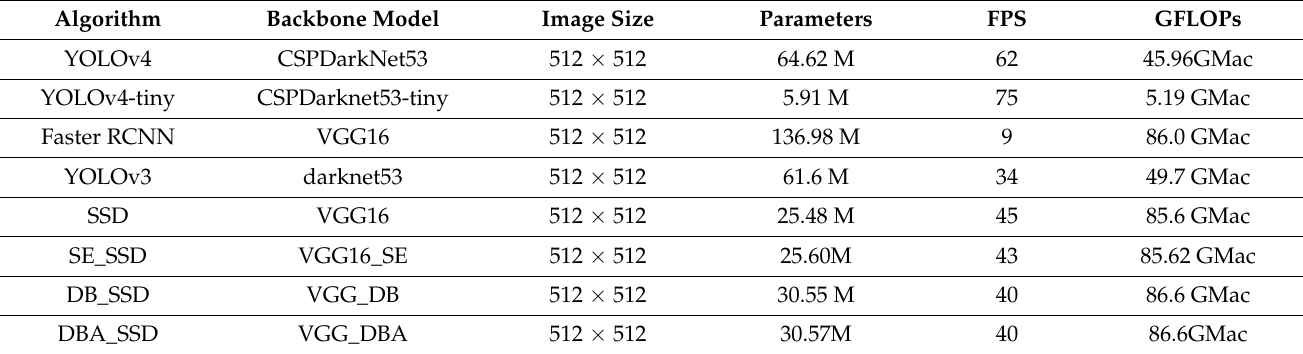
Table 4. Performance comparison of target detection algorithms.